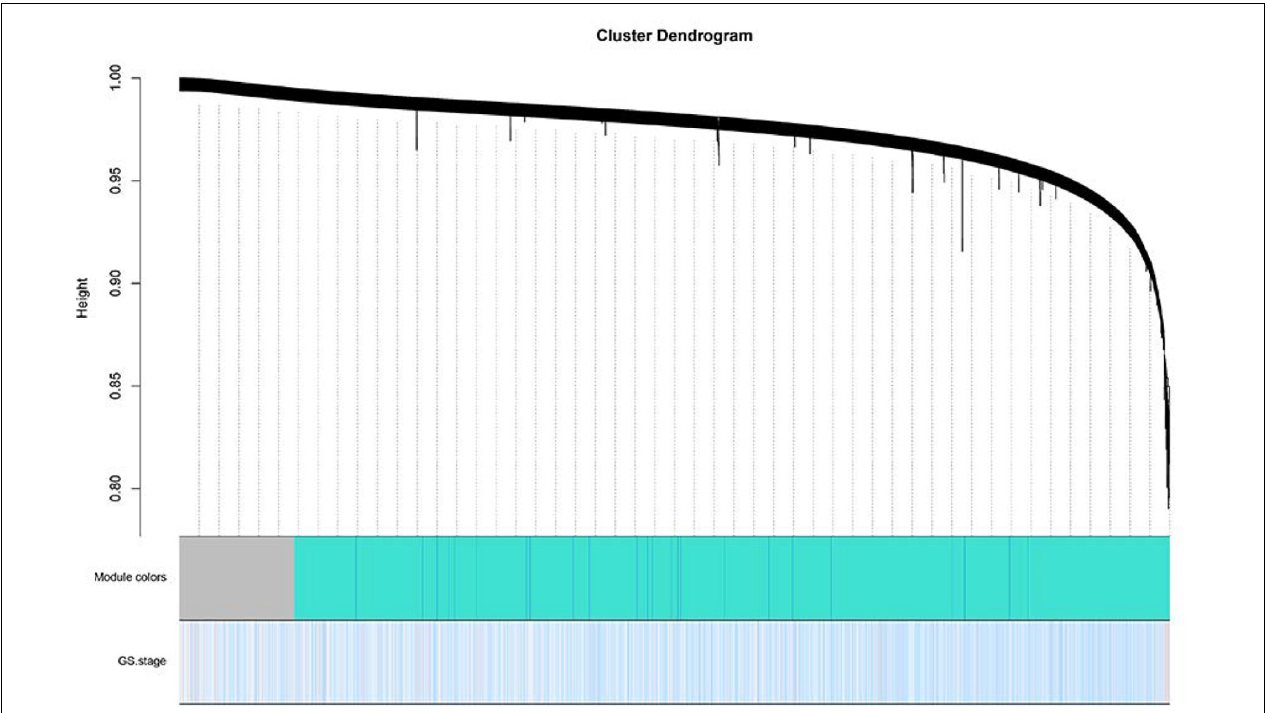
FIGURE 5 | Dendrogram of all differentially expressed genes clustered based on a dissimilarity measure. Dynamic tree cutting was applied to identify modules by dividing the dendrogram at significant branch points. Modules associated with tumor stage are displayed with different colors in the horizontal bar.